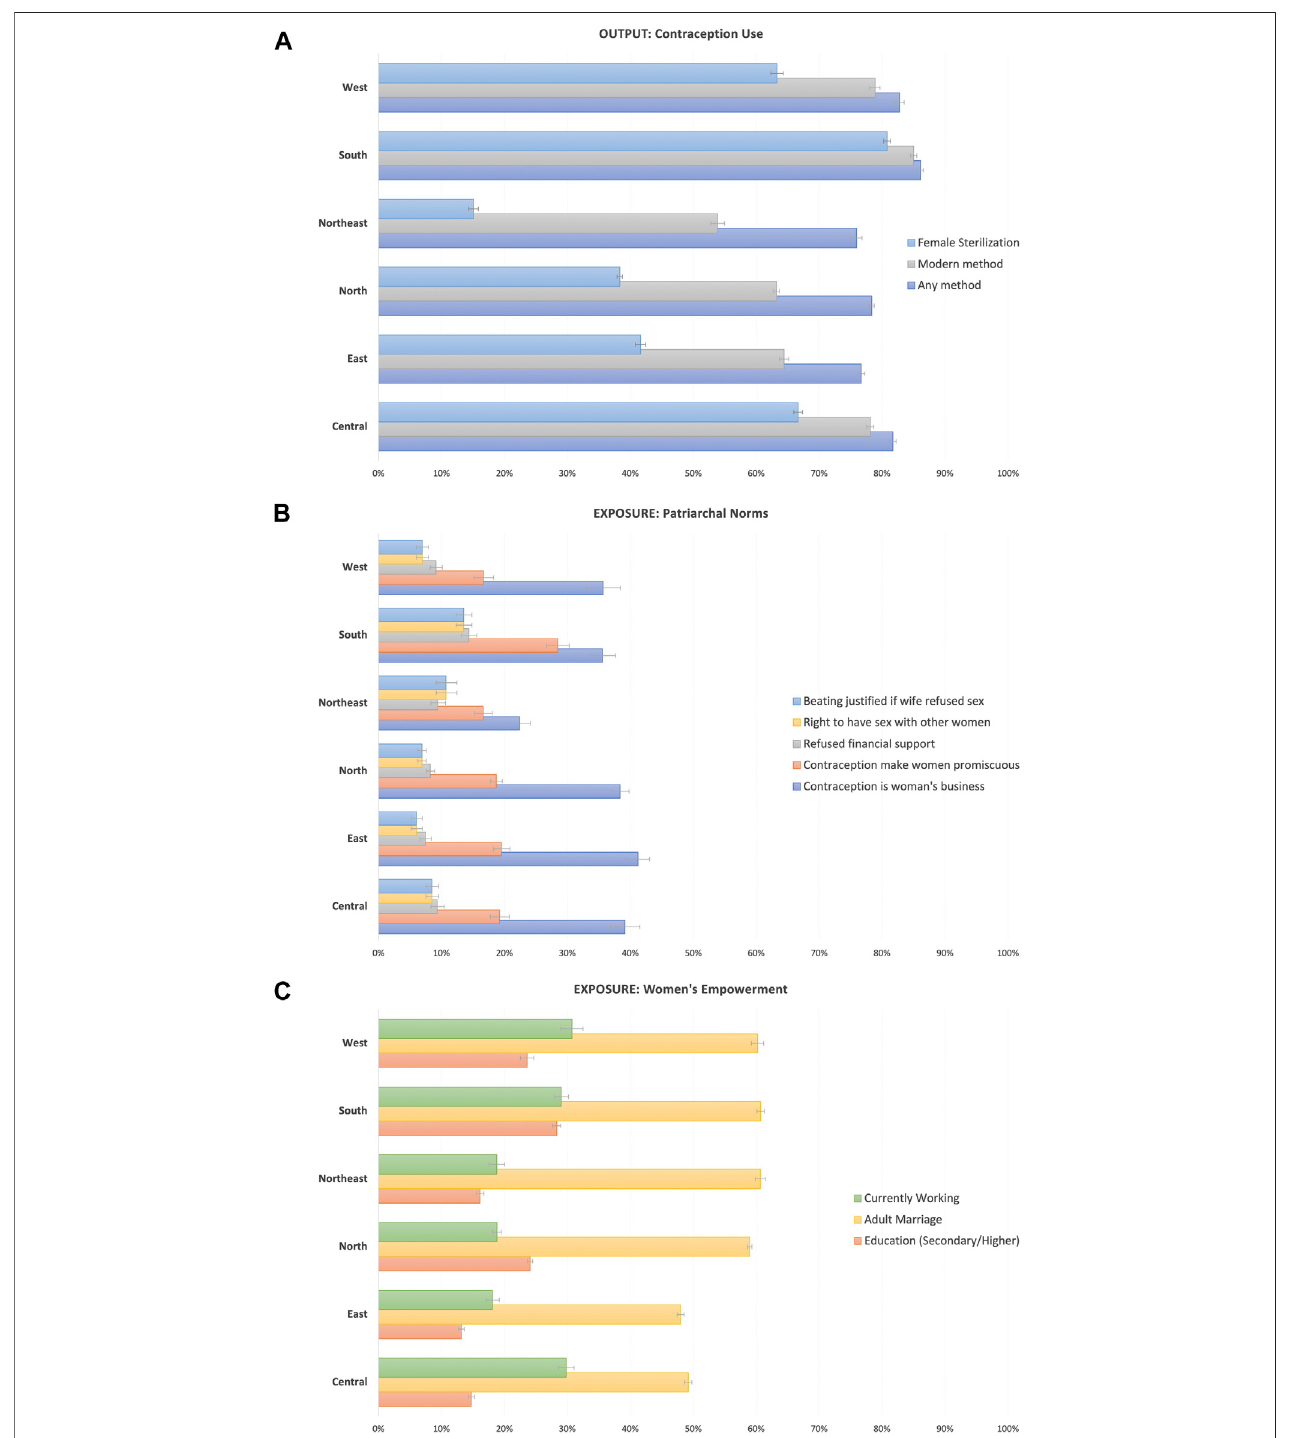
FIGURE 2 | Regional-level percentage of women using contraception (A) , men ’ s attitudinal norms (B) , and women ’ s empowerment (C) . Note: For robustness, district -level percentages were obtained after further excluding districts with less than 20 observations, which were comprised of 1,169 individuals in the male sample and 37 individuals in the female